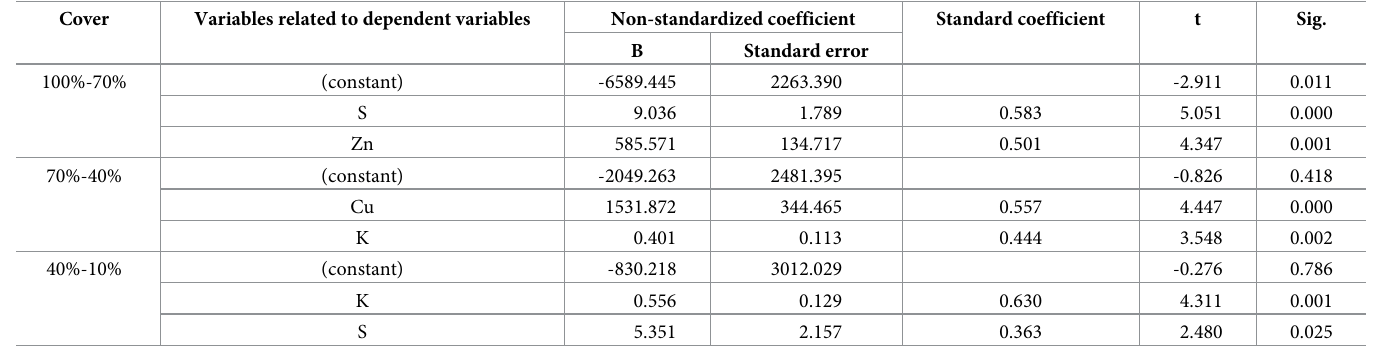
Table 3. Stepwise regression of the relationships between N and other elements in L . chinensis . Cover